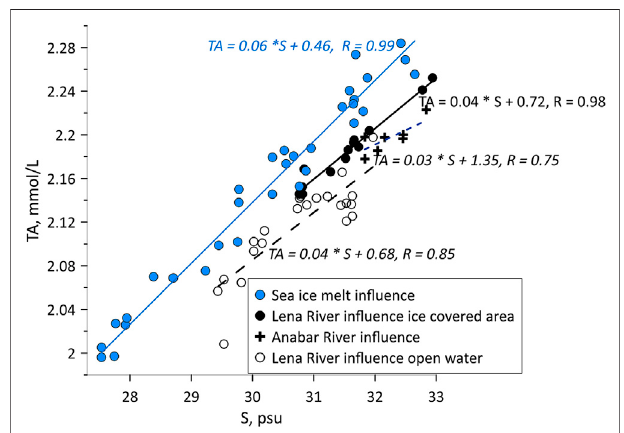
FIGURE 5 | Total alkalinity – salinity plot for PML along the section A and EES sections. Black and empty circles show Lena River ice meltwater fraction at the ice-covered and ice free stations, respectively. Black crosses show Anabar River ice meltwater fraction at the ice-covered stations. Blue circlesshowtheseaicemeltwaterfraction.Risthecorrelationcoef fi cient.Free terms in linear approximation equation TA (S) = kS + TA end correspond to alkalinity of meltwater from estuarine ice or sea ice, respectively, pointing to signatures of freshwater